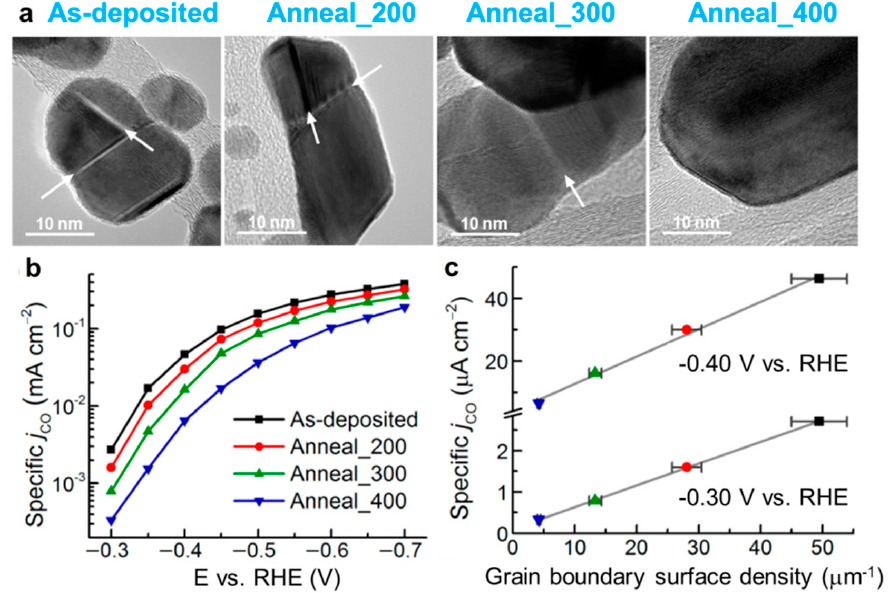
Figure 11. ( a ) TEM images of as − deposited and annealed Au/carbon nanotubes electrodes. ( b ) Spe- cific current density for CO production (j CO ) vs. potential and its ( c ) correlation with grain boundary surface density. Reproduced with permission [83]. Copyright 2015, American Chemical Society.